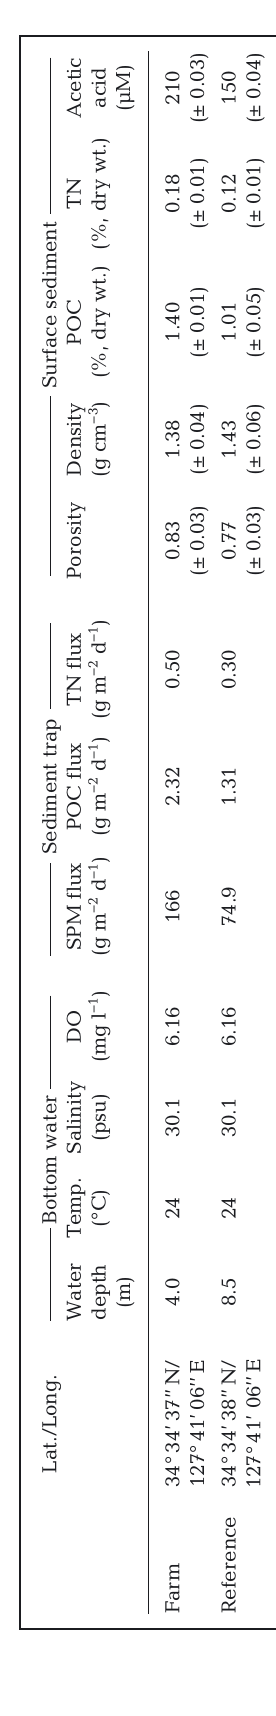
SRR and dsr gene copy number SRR ranged from 753 to 1957 nmol cm −3 d −1 at 41 the farm site and from 22.1 to 77.0 nmol cm −3 d −1 at 127 ° the reference site (Fig. 3A). Average SRR at the farm site (1209 nmol cm −3 d −1 ) was 19-fold higher than that measured at the reference site (62.1 nmol cm −3 d −1 ). The abundance of dsr gene copy number ranged from 1.1 × 10 9 to 3.4 × 10 9 copies cm −3 at the farm site and from 4.3 × 10 8 to 1.3 × 10 9 copies cm −3 at the ref-